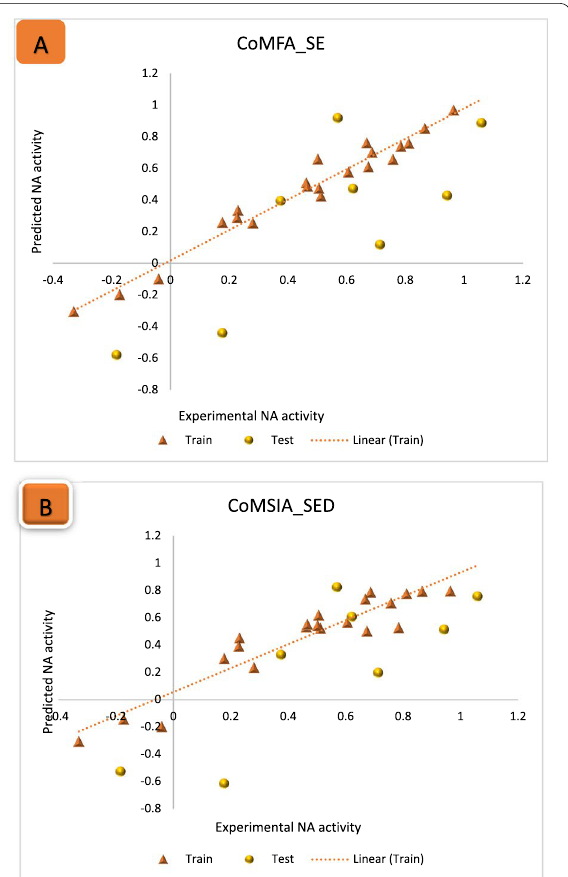
Fig. 6 Scatter plot of predicted against experimental NA inhibitory activity: A CoMFA_SE model, B CoMSIA_SED